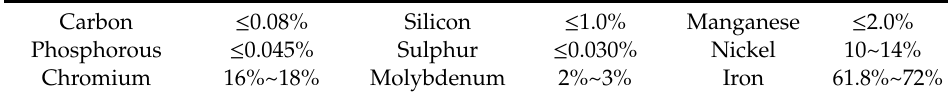
Table 3. Chemical composition of (American Society for Testing and Materials) ASTM A240 Grade 316 Stainless Steel.